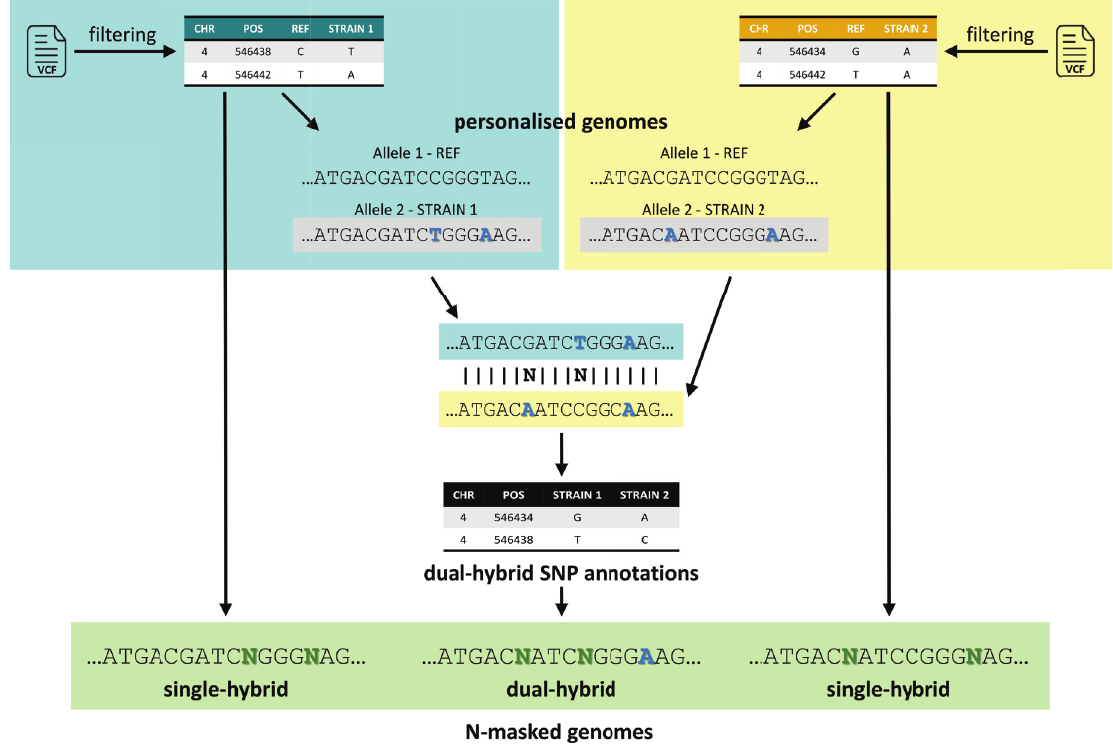
Figure 1. Generating N-masked or personalised genomes. Single-hybrid strains require SNP information/filtering from only one strain (Strain 1, blue box). SNP positions against the referene genome (REF) can either be masked by Ns (N-masked genome) or incorporated unmasked as full sequence (personalized genome). Dual hybrid strains require the SNP information/filtering also from a second strain (Strain 2, yellow box). The SNP information of Strain 1 and Strain 2 are then compared to create dual-hybrid SNP annotations (note